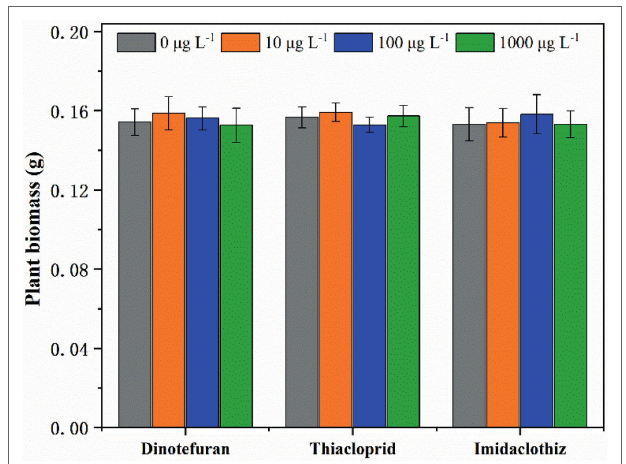
FIGURE 4 | Plant biomass of Lemna aequinoctialis in toxicity experiments with NEOs. Error bars indicate the standard deviations ( n =